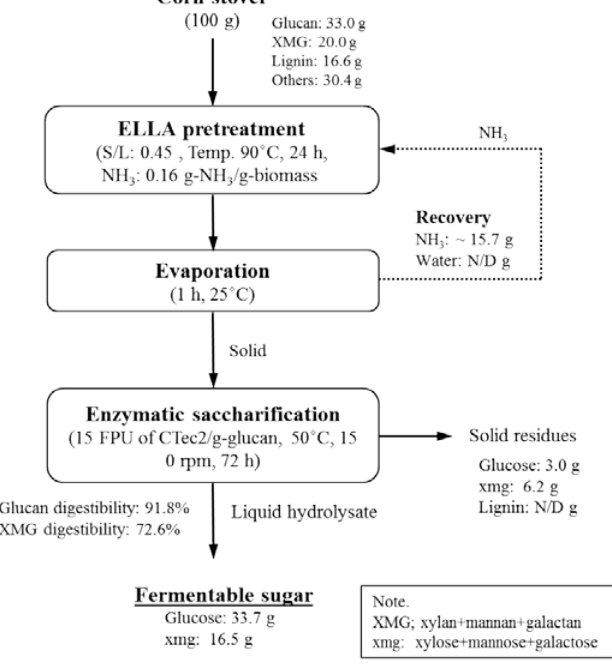
Figure 6. Schematic diagram and mass balance during conversion of corn stover to sugars.